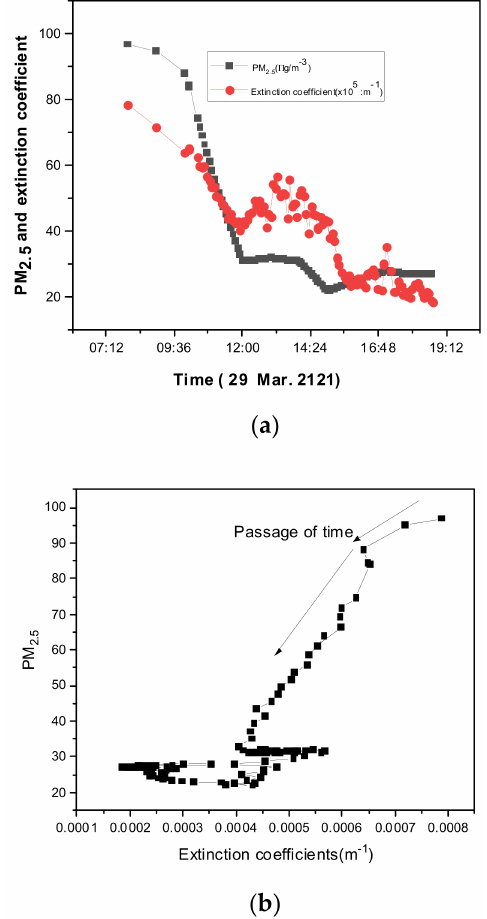
Figure 13. Temporal changes in the extinction coefficients (blue) and PM 2.5 values obtained on the same date with the disappearance of the dust storm. ( a ) Temporal changes in PM 2.5 values and extinction coefficients (blue). ( b ) Correlation between PM 2.5 values and extinction